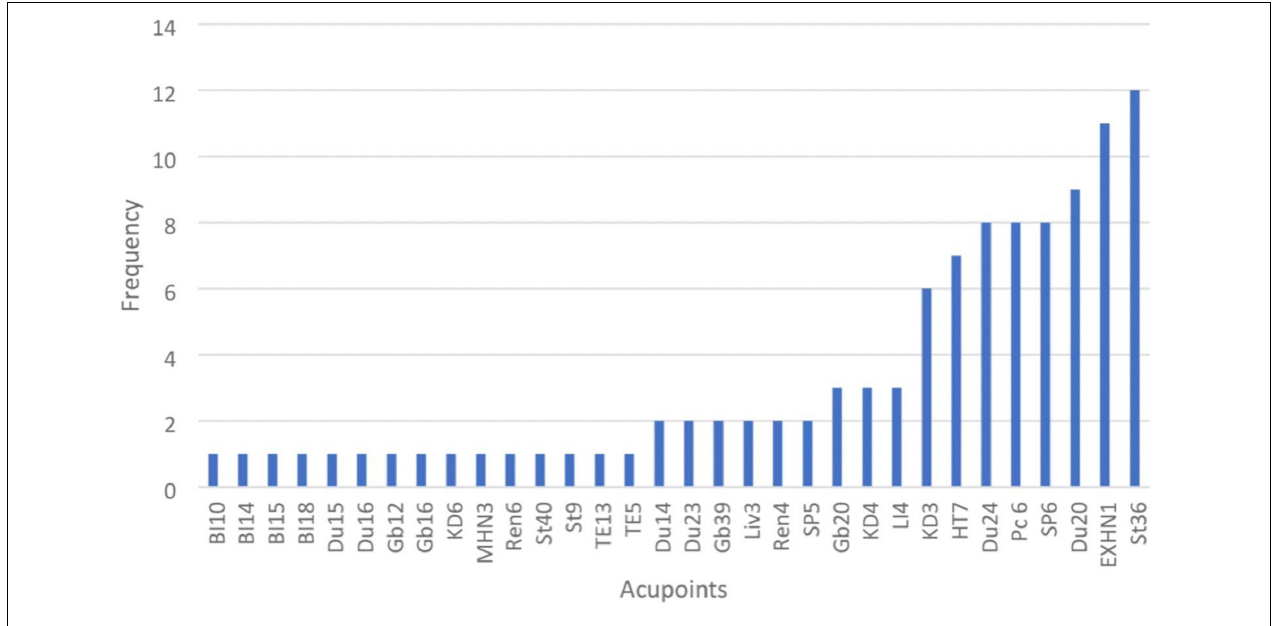
FIGURE 1 | Distribution of acupoints used in the randomized control trials (RCTs).